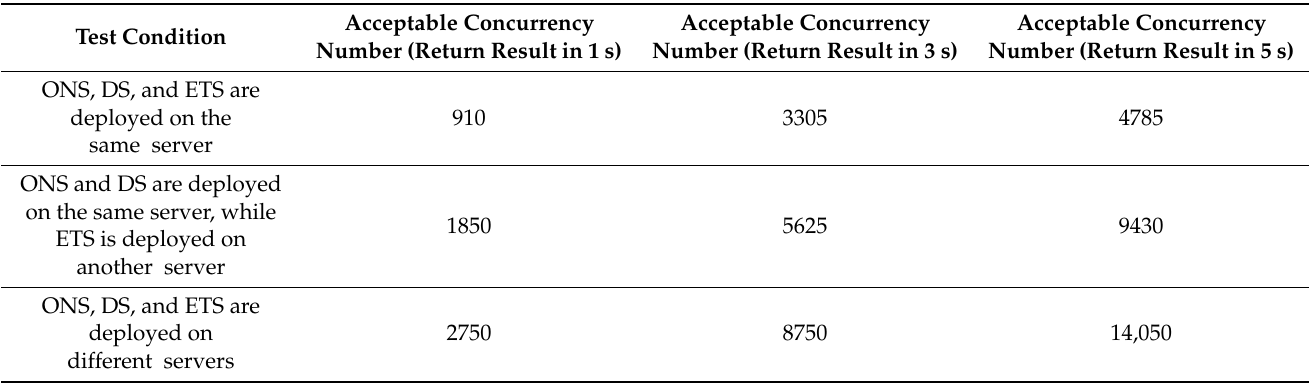
Table 6. The load test results under different